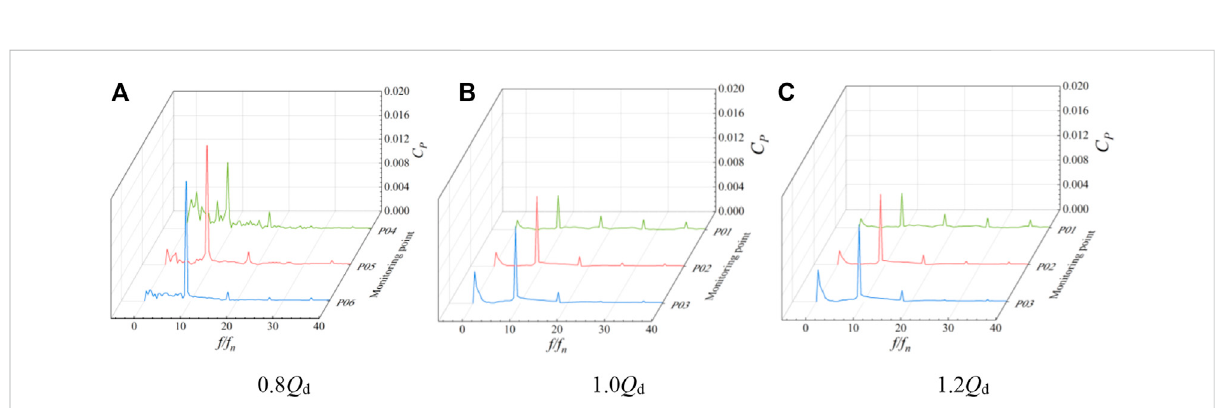
FIGURE 17 Pressure pulsation spectrum of monitoring points 4 – 6 between the impeller and guide vane body at different fl ow rate